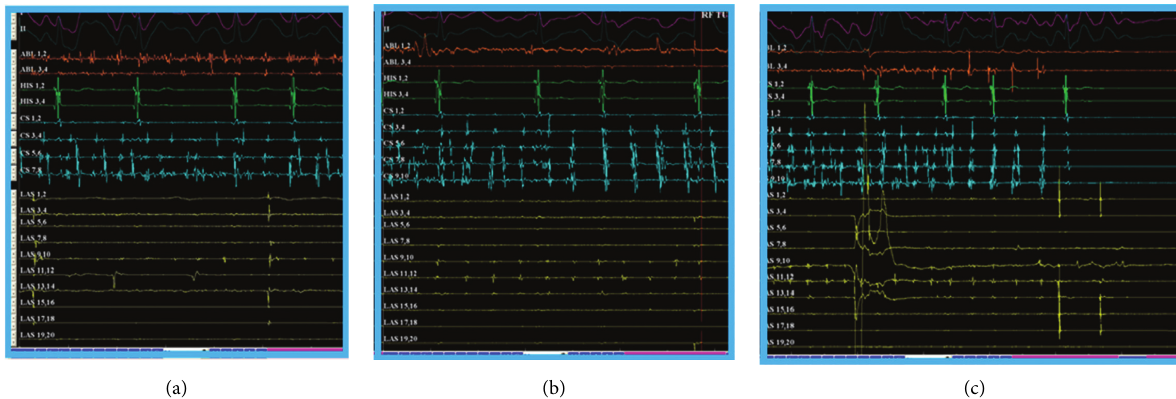
Figure 11: Organization and termination of persistent AF with ablation of CFAEs. (a) Recording of fragmented potentials at the base of the LAA at the onset of ablation. (b) Organization of arrhythmia shortly before termination. (c) Termination of the arrhythmia during ablation in the same